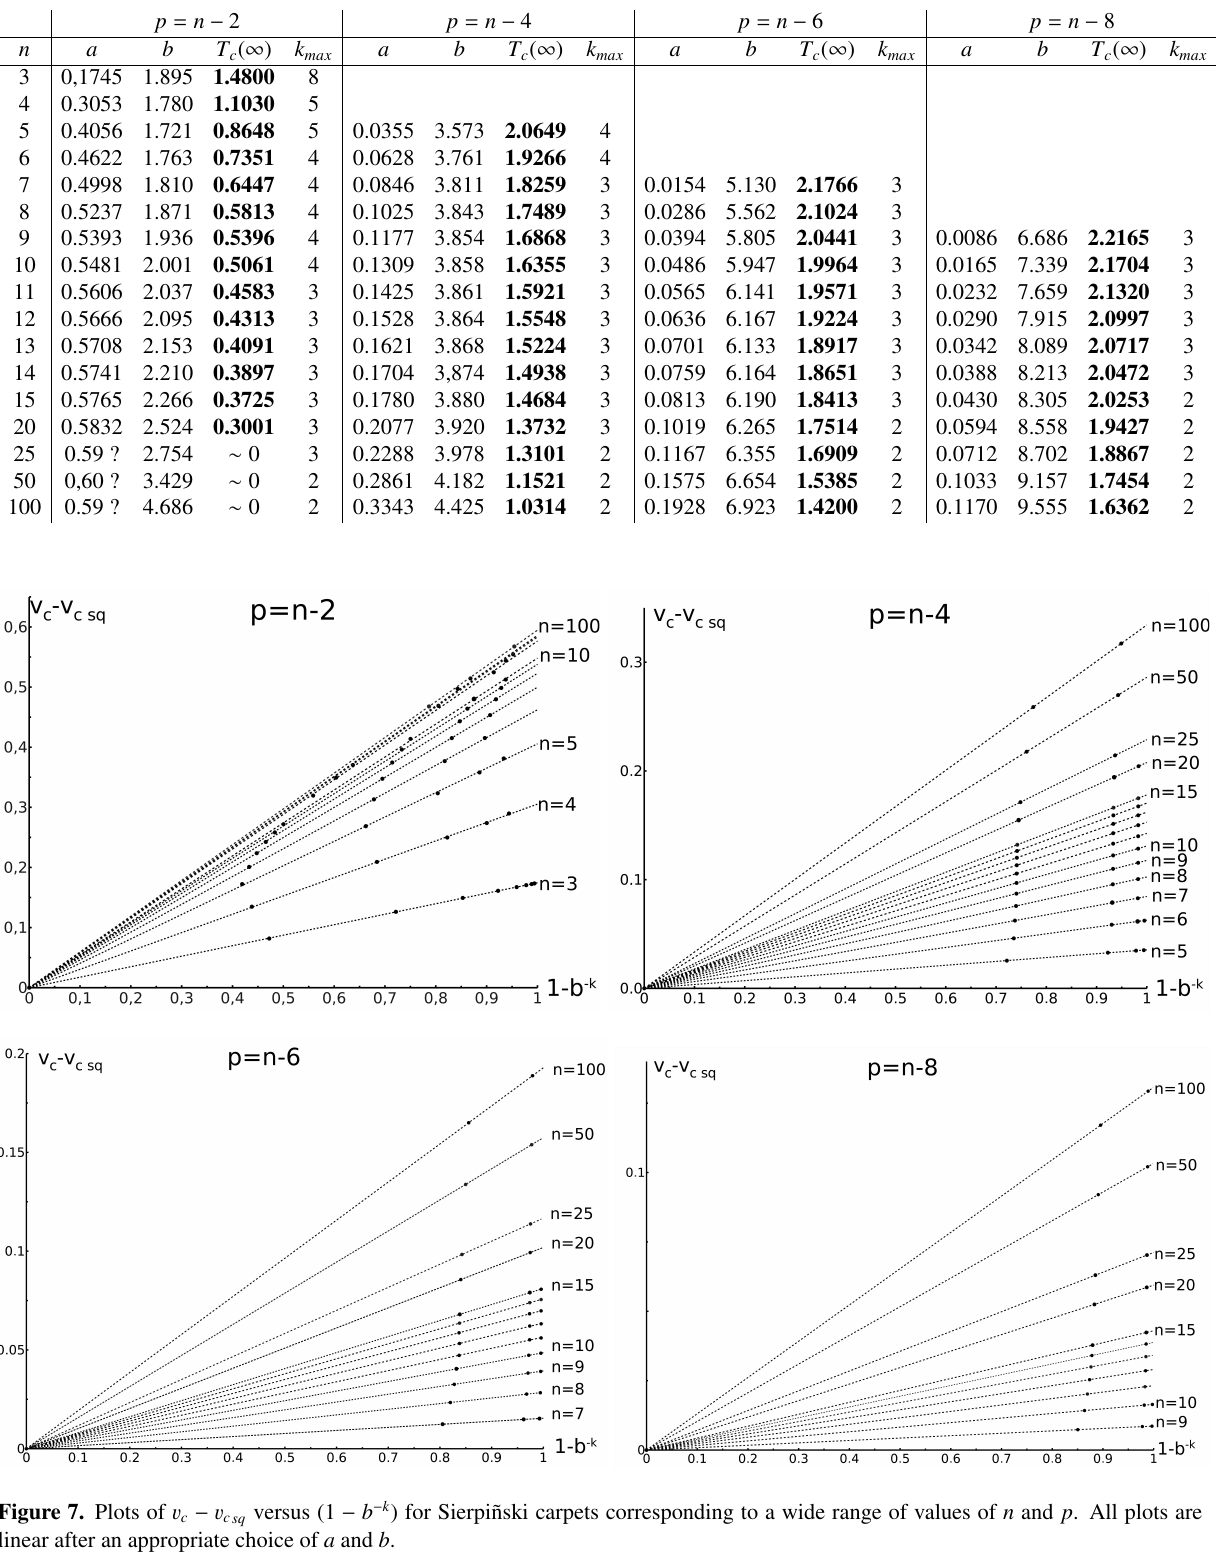
Table 1. Values of a , b of eq. (1) and of T c ( k = 1 ) (enlighted in boldfaces), k max is the highest segmentation step used for calculations.